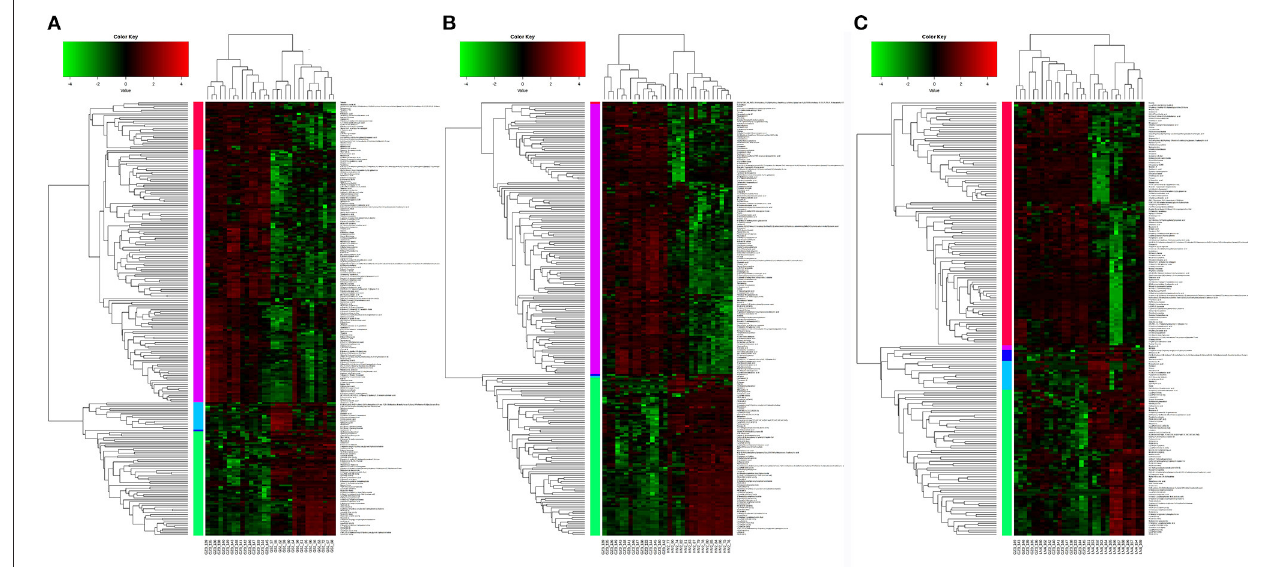
FIGURE 3 | Hierarchically clustered heatmap of differential metabolites. (A) Gansu vs. Guizhou, (B) Henan vs. Guizhou, and (C) Liaoning vs. Guizhou.